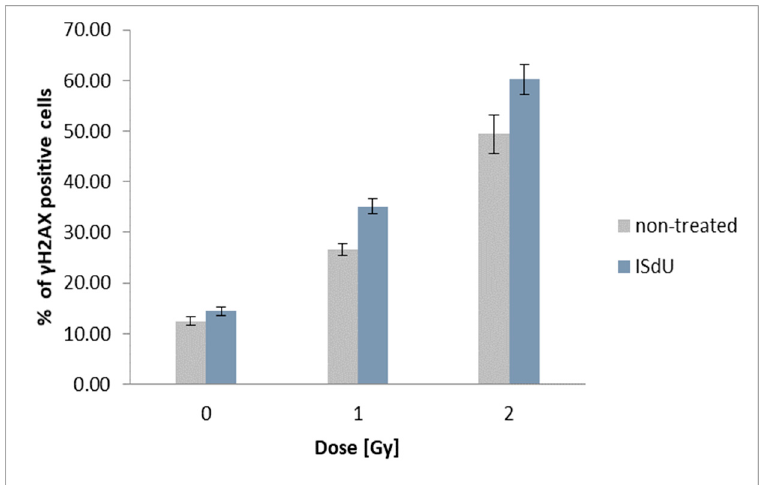
Figure 4. Flow cytometric analysis of H2A.X phosphorylation. γ H2A.X was measured 1 h after irradiation. Results are shown as the mean ± standard deviation (SD) of three independent flow cytometry experiments.